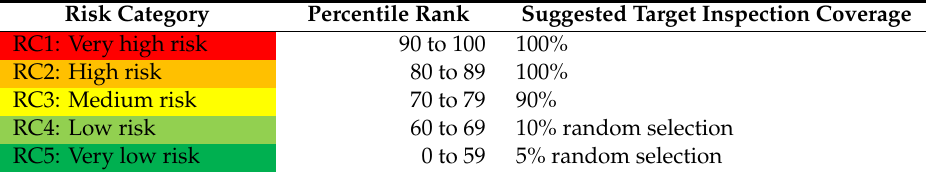
Table 4. Risk categories and suggested yearly target inspection